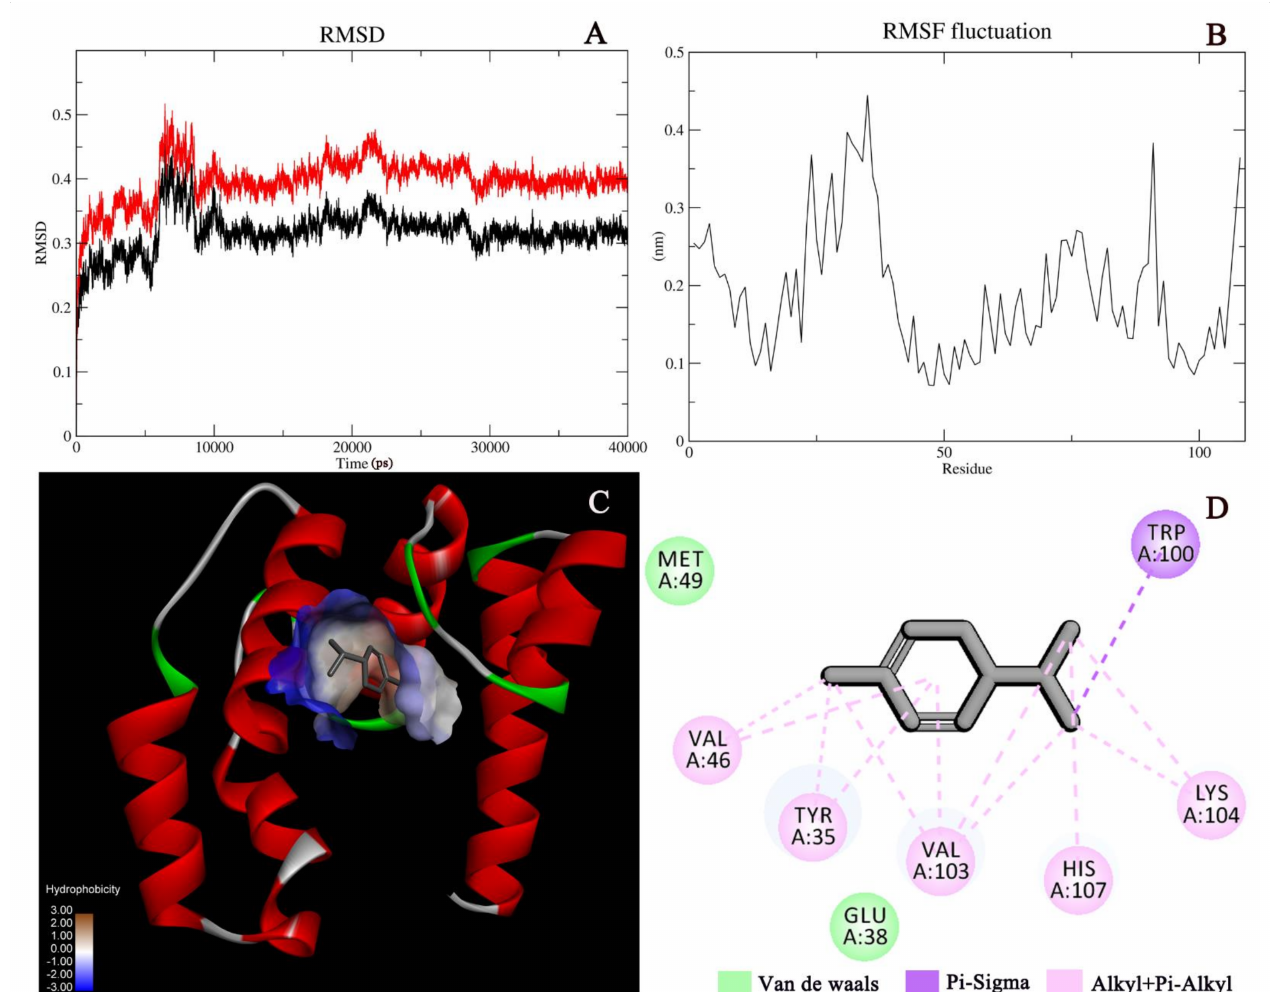
Figure 4. Molecular docking index of the EsigGOBP1 –alpha-phellandrene complex. The root-mean- square deviation (RMSD) values for carbon backbones of the EsigGOBP1 –alpha-phellandrene complex during the 40 ns molecular dynamics (MD) simulations ( A ); Residue fluctuations for the EsigGOBP1 – alpha-phellandrene complex during the 40 ns MD simulations ( B ); Canonical conformations of the EsigGOBP1- alpha-phellandrene complex. ( C ) Interactions in the EsigGOBP1- alpha-phellandrene complex ( D